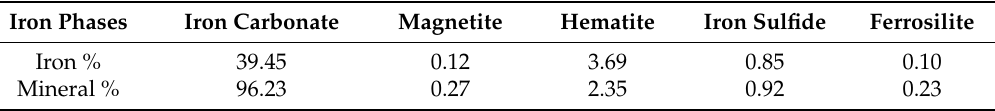
Table 2. Iron mineral analysis of pure siderite mineral (in mass